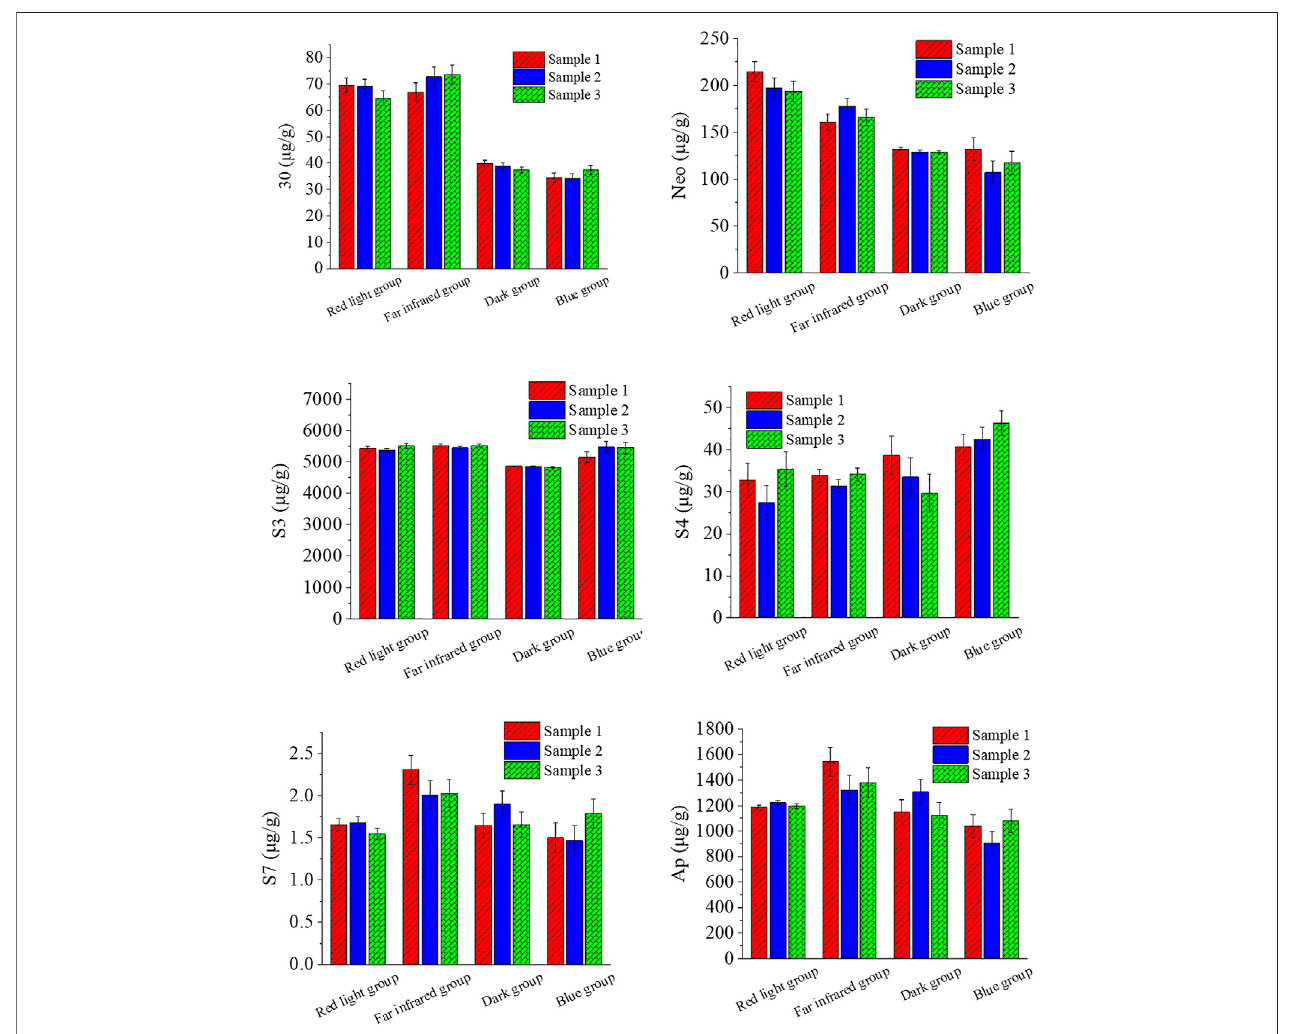
FIGURE 2 | Effect of other light treatments on the chemical composition of A. paniculata seedlings.